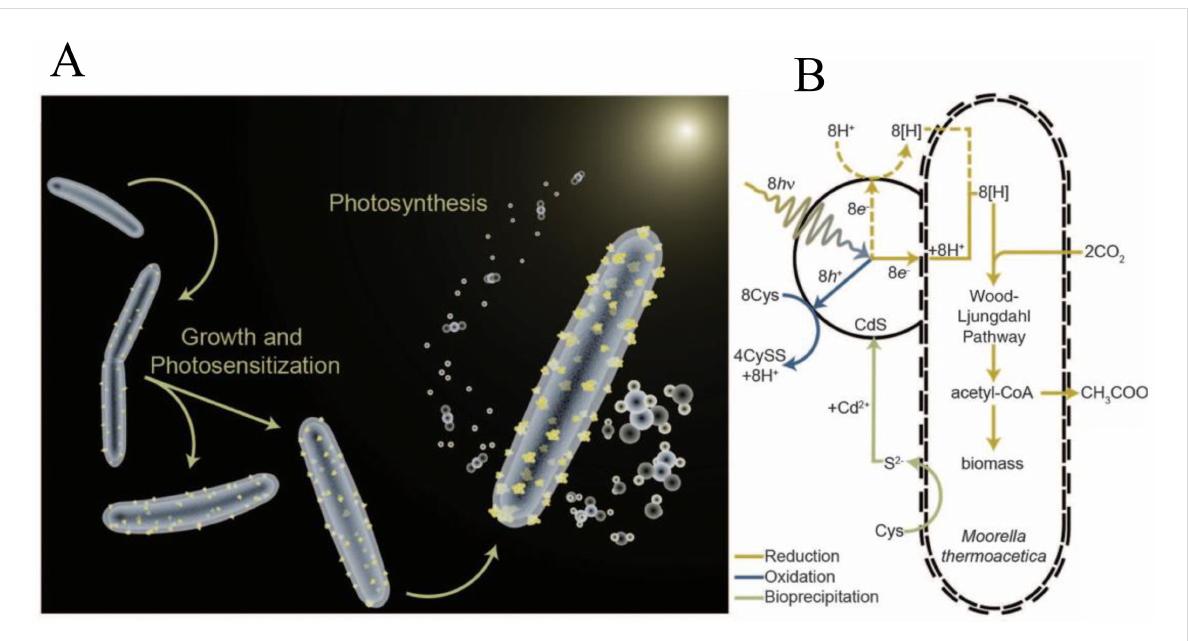
Figure 7: (A) Bacterium–CdS hybrid system that has CdS nanoparticles on the bacterium membrane (yellow particles). (B) Pathway diagram for the light harvesting and the photosynthetic conversion of CO 2 to acetic acid with the bacterial enzyme system. Adapted from [79], copyright 2016 Amer- ican Association for the Advancement of